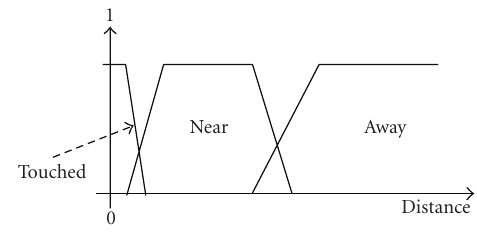
Figure 5: Membership function of distance.